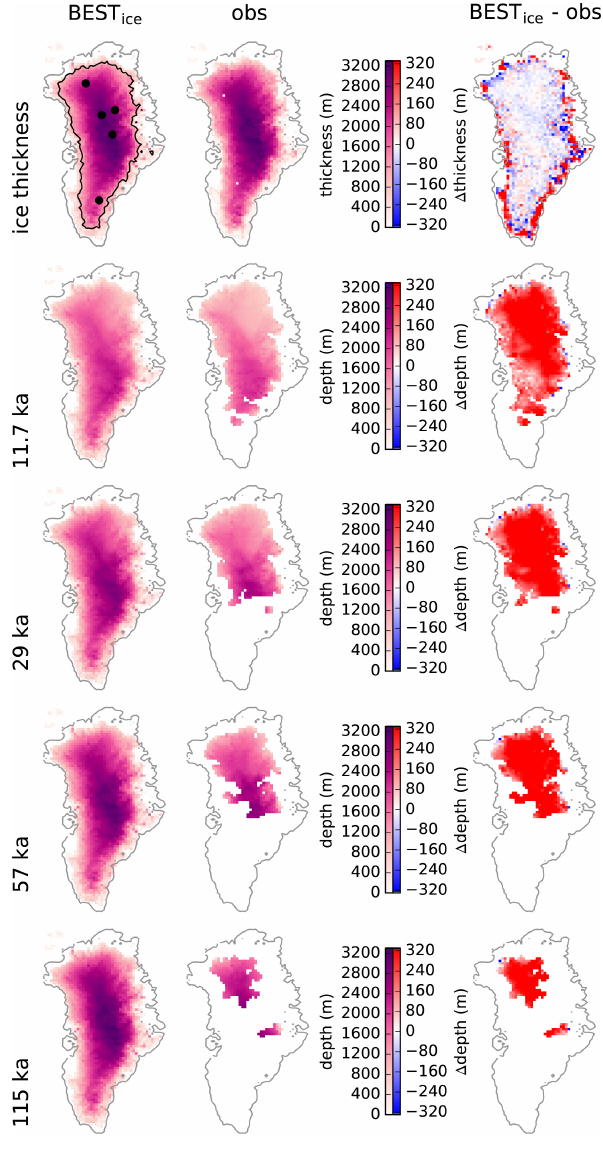
Figure 5. Ice thickness and isochrone depth for the simulation BEST ice , observations, and the respective differences. Top left panel shows the 1km ice thickness contour and selected ice core lo- cations from north to south: NEEM, EGRIP, NGRIP, Summit, and